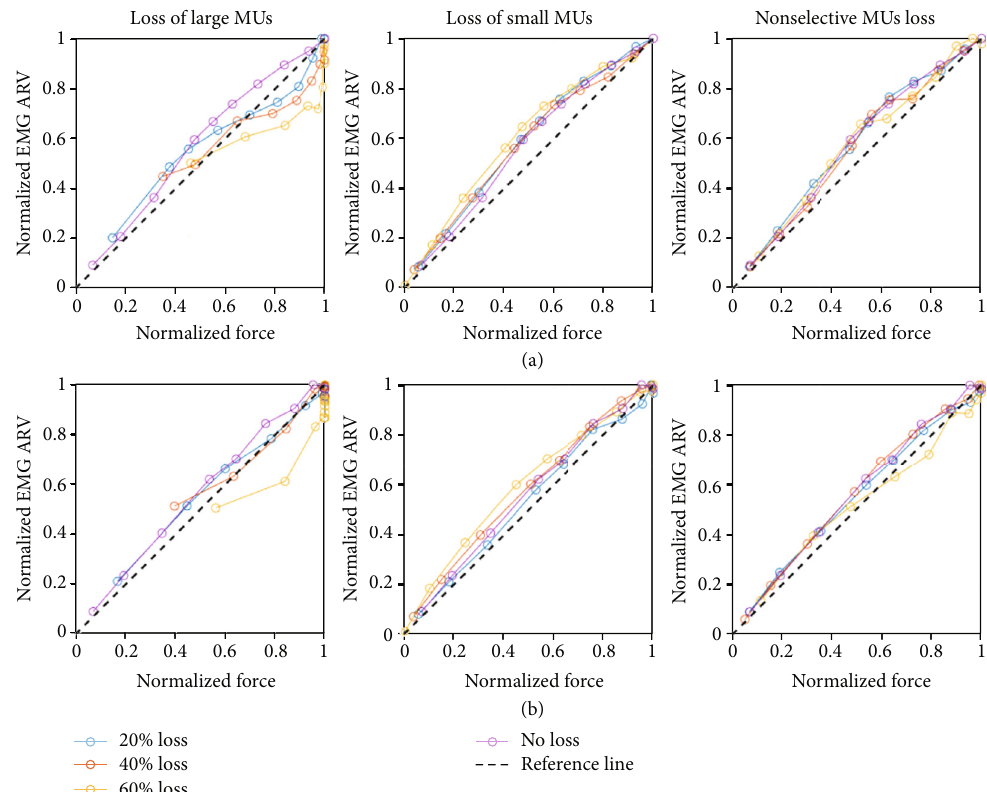
Figure 6: The simulated EMG-force relation for di ff erent patterns and levels of motor unit loss in (a) the “ onion skin ” and (b) reverse “ onion skin ” motor unit fi ring